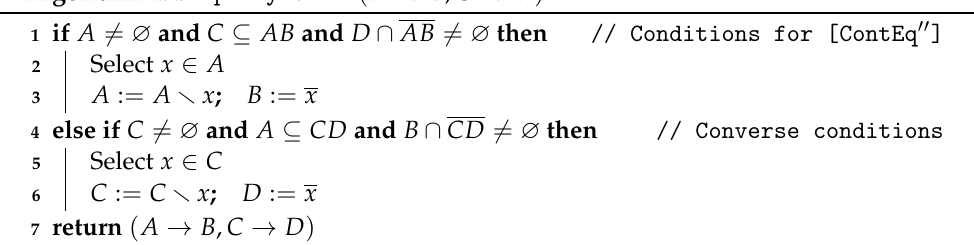
Algorithm 2: Simplify-Cont2 ( A